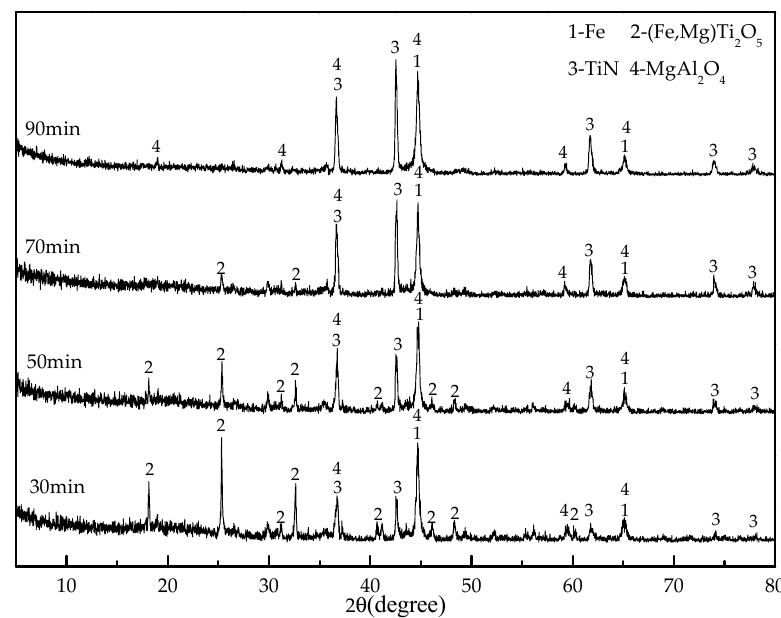
Figure 4. XRD patterns of pellets with 26 wt % reduced at 1300 °C after different time.